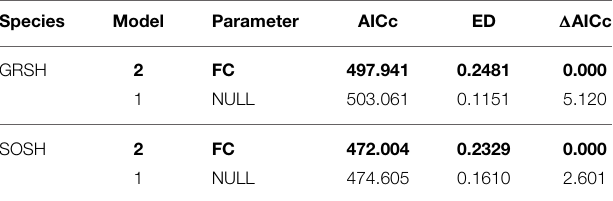
Candidate models are ordered based on the corrected Akaike Information Criteria (AICc). Selected models are inbold. ED, Explained deviance; GRSH and SOSH denote great and sooty shearwaters,